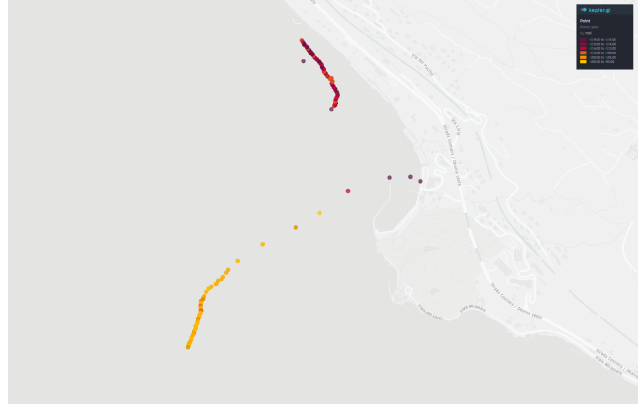
Figure 6. Gateway coverage in terms of Received Signal Strength Indicator